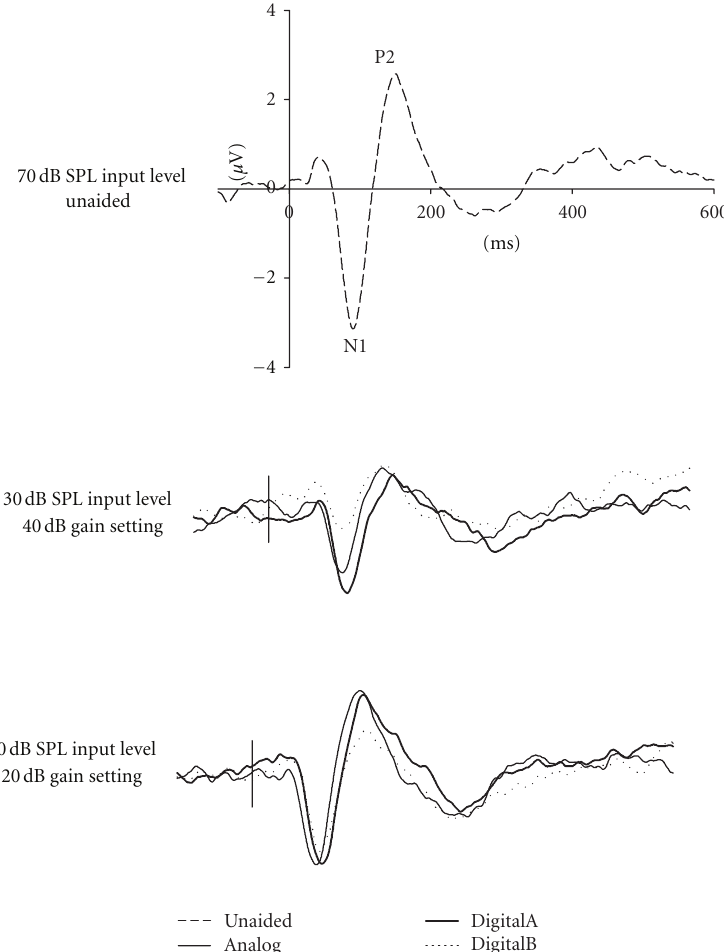
Figure 3: Grand mean ( N = 13) waveforms for 70 dB SPL equivalent nominal output for unaided and aided conditions (Analog, DigitalA, and